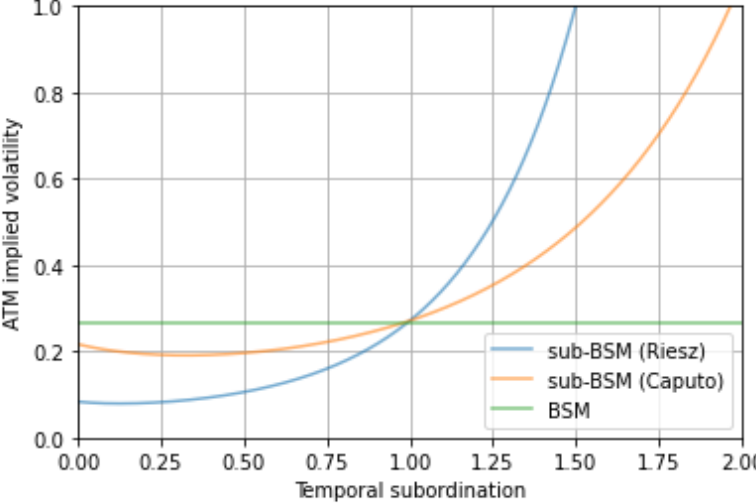
Figure 1. At the money forward (ATMF) implied volatility in two subordinated Black-Scholes-Merton (BSM) models (via a Riesz derivative or a Caputo derivative), and in the BSM model. As expected, they all coincide when the order of the temporal derivative is equal to 1. Parameters: K = 4000, r = 2%, q = 1%, and τ =